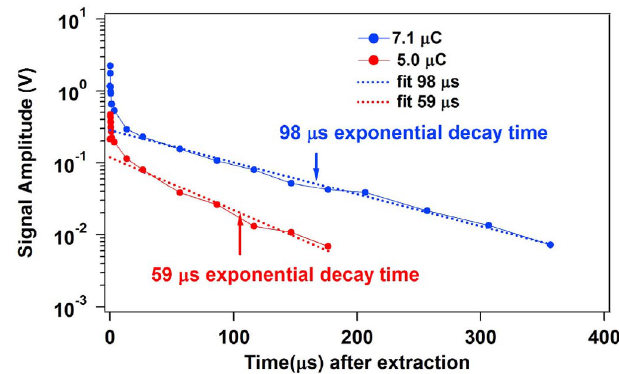
FIG. 8. (Color) Trapped electron dissipation/decay curves for ES43Q amplitude data of 9 = 16 = 06 taken at two beam intensities, 7 : 1 (cid:1) C = pulse and 5 : 0 (cid:1) C = pulse . The exponential decay times shown were obtained from fits to the portion of the curves after (cid:1) 15 (cid:1) s